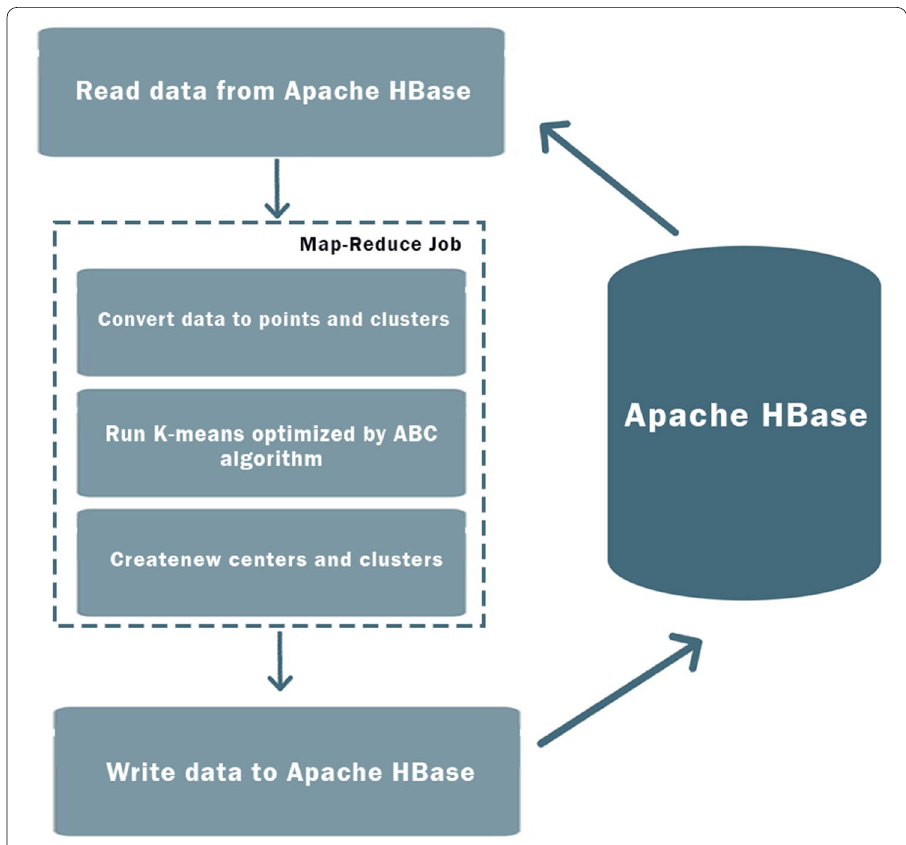
Fig. 5 Overall procedure of each iteration of proposed